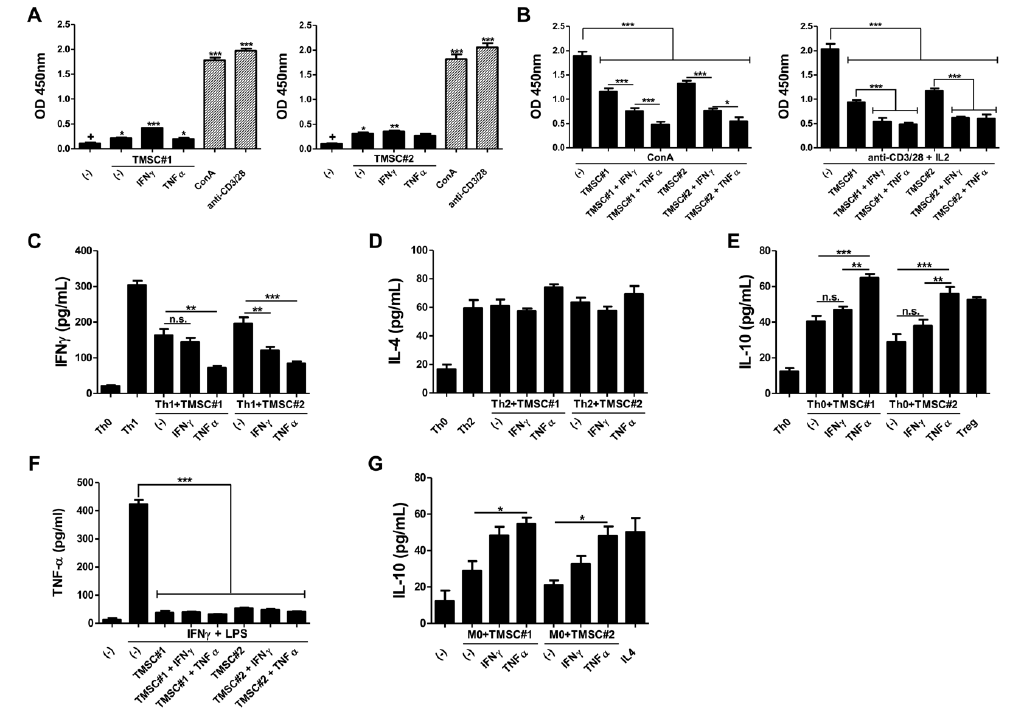
Figure 3. Enhanced immunomodulatory potency of TNF- α -primed TMSCs. TMSCs isolated from two di ff erent individuals were cultured for 24 h in the absence or presence of either IFN- γ or TNF- α . ( A ) Naïve or primed TMSCs were cocultured with PBMCs without any stimulants to assess the immunogenicity and proliferation of PBMCs was determined using BrdU cell proliferation ELISA kit, compared to ConA- or anti-CD3 / 28-treated PBMCs as positive controls; ( B ) Naïve or primed TMSCs were cocultured with PBMCs in the presence of ConA or anti-CD3 / 28 plus IL-2 and the